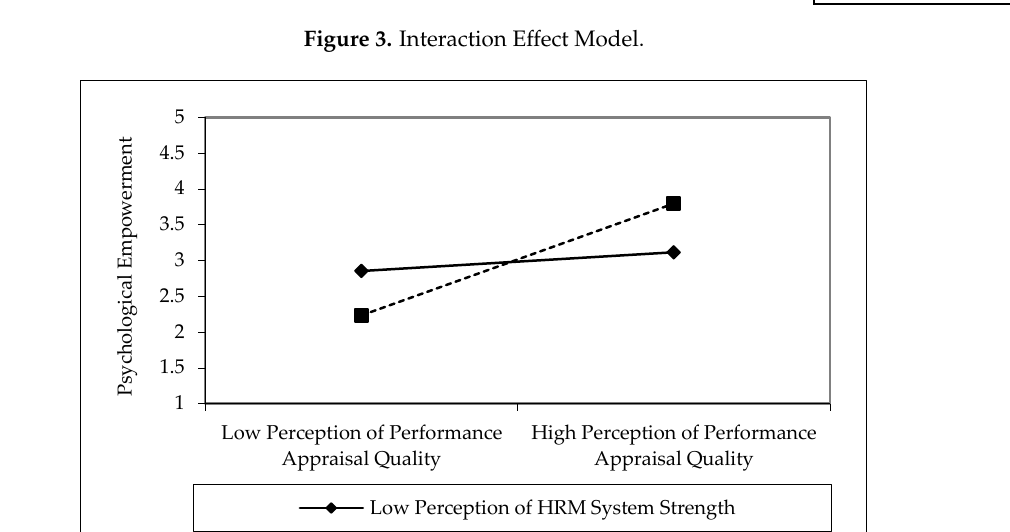
Figure 3. Interaction Effect Model.